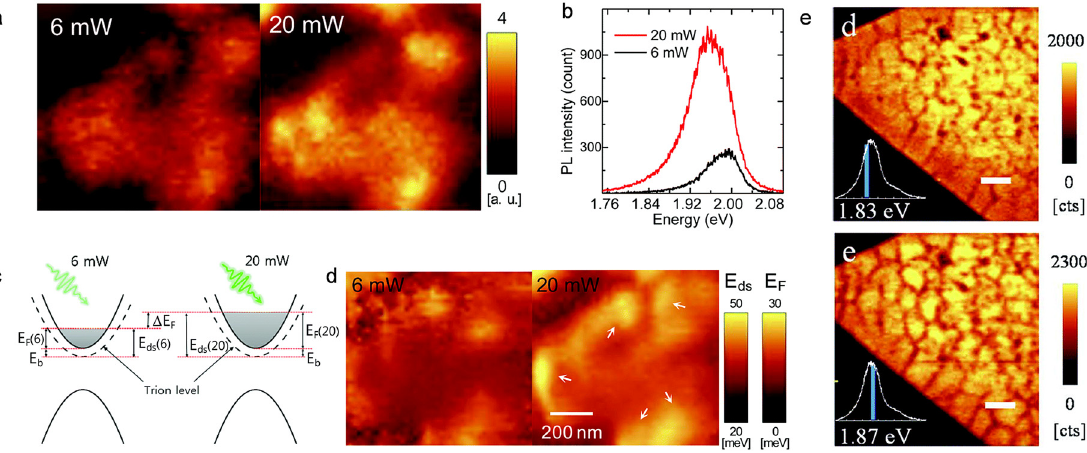
Figure 4: Local charge population of 1L-WS 2 . (a)Near-fieldimageoftheratiooftrionemissiontoexcitonemissionat6and20mW,respectively.(b)Representativenear- fi eldPLspectra.(c) Schematic energy band diagram to explain the relation between trion dissociation energy ( E ds ), trion binding energy ( E b ) and Fermi level ( E f ). (d) Near- fi eld images of E ds or the estimated E F assuming E b of 20 meV at 6 and 20 mW. Reproduced with permission from ref. [34]. Copyright 2018, Royal Society of Chemistry. (e) Near- fi eld PL images of trion and exciton of 1L-MoS 2 , respectively. Reproduced with permission from